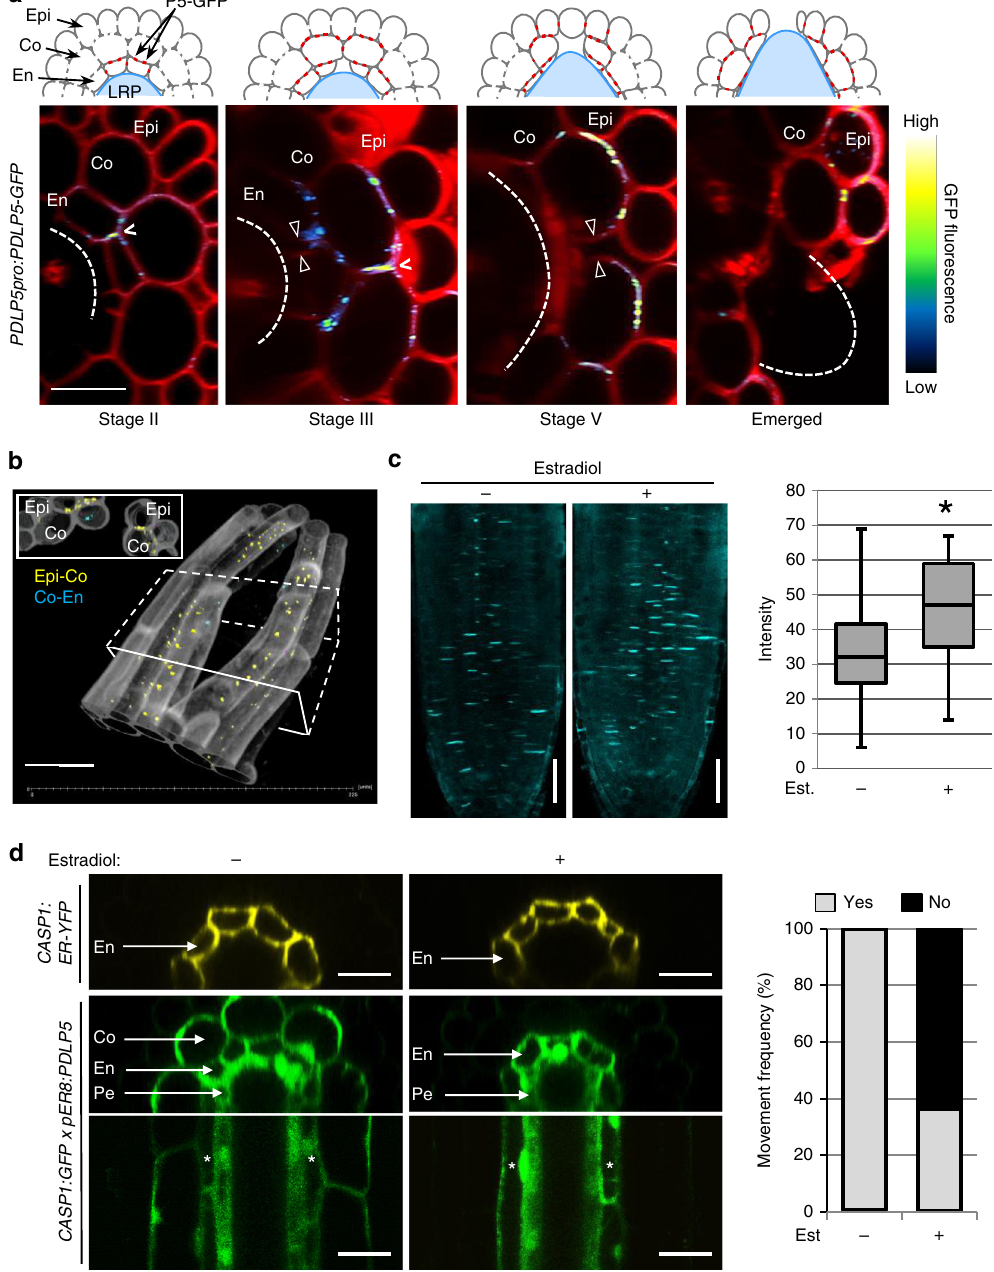
Fig. 2 PDLP5 localizes to plasmodesmata in LRP-overlying cells. a Representative confocal images showing 2D maximum intensity projections of 10 μ m- thick cross-sections of PDLP5pro:PDLP5-GFP . Plasmodesmata marked by punctate PDLP5-GFP signal (in cartoons, red dots) can be seen at the cell junctions. PDLP5-GFP signals vary in color ranging from blue to green, yellow, and white depending on fl uorescence intensity as indicated in calibration bar of the fl uorescence intensity included on the right. The dashed arcs are positions of LRP; open arrowheads, separated cell walls; carets, strong PDLP5-GFP signal in cell walls just prior to separation. Scale bars, 25 μ m. b A representative 3-D rendering of a confocal image, showing a 2-D maximum intensity projection of a 45 μ m-thick cross-section of cells overlying an emerged LRP (not rendered) in PDLP5pro:PDLP5-GFP root. Signals at other junctions (Co – Co, Ep – Ep) were rare at the emergence stage we used for modeling. Inset, a cross-sectional view of the image taken from the boxed area. PDLP5-GFP-labeled plasmodesmata in different cell junctions are color-coded. c pER8:PDLP5 root tips stained with aniline blue after 24 h of 10 µ M estradiol or mock treatment. Estradiol- and mock-treated n = 25; scale bars, 25 µ m. d PDLP5 induction can prevent GFP movement from En to Co root tissue in pER8:PDLP5 × CASP1:GFP F2 crosses. Mock n = 24, Treated n = 47; scale bars, 20 μ